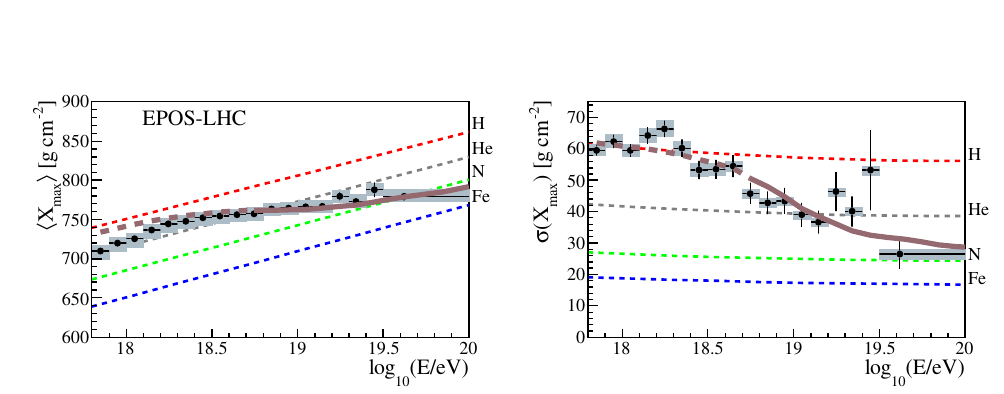
Figure 2. Average and standard deviation of the X max distribution, compared to those predicted assuming EPOS- LHC interactions for pure H (red dashed lines), He (grey), N (green) and Fe (blue). Also shown with brown lines are the predictions [14] from the model with mixed composition illustrated in the right panel of figure 1, for which only the energy range where the brown lines are solid is included in the